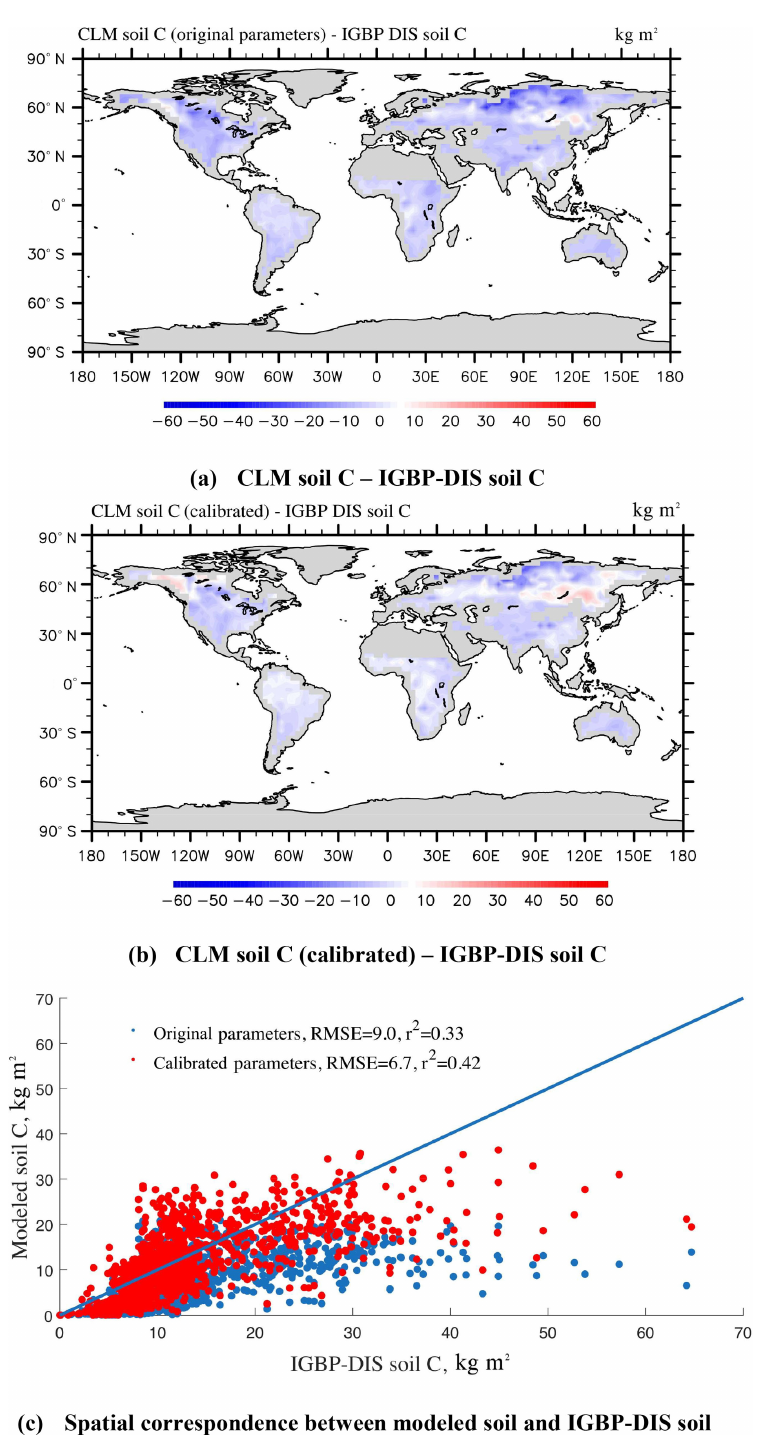
Figure 7. Spatial correspondence of SOC produced by CLM-CASA’ to SOC reported by IGBP-DIS. Map (a) shows the results using the default parameter values, and (b) shows the results after parameter calibration using the surrogate-based optimization. The points in (c) represent the grid cell values (blue represents the results with default parameter values and red represents the results after parameter calibration). CLM-CASA’ with the default parameter values explains 33% of the variation in the observed soil C, while CLM-CASA’ with the calibrated parameter values explains 42% of the variation in the observed soil